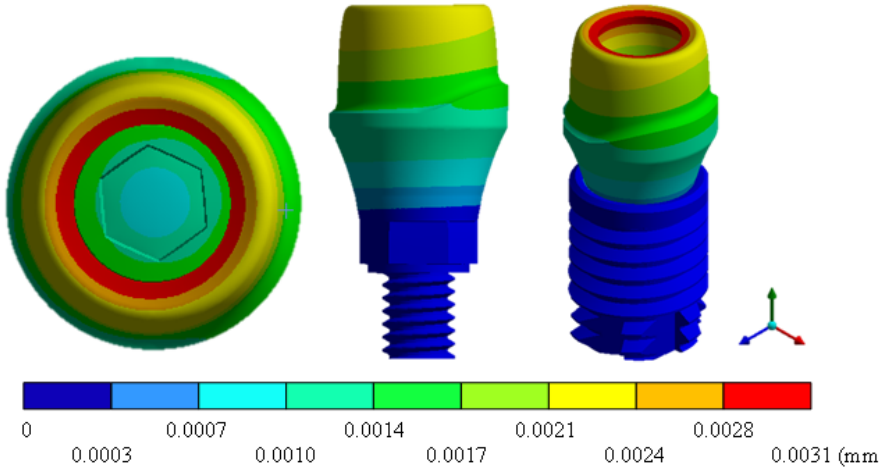
Figure 21. Total general displacement for On1 Esthetic-type implant (ZrO 2 ).